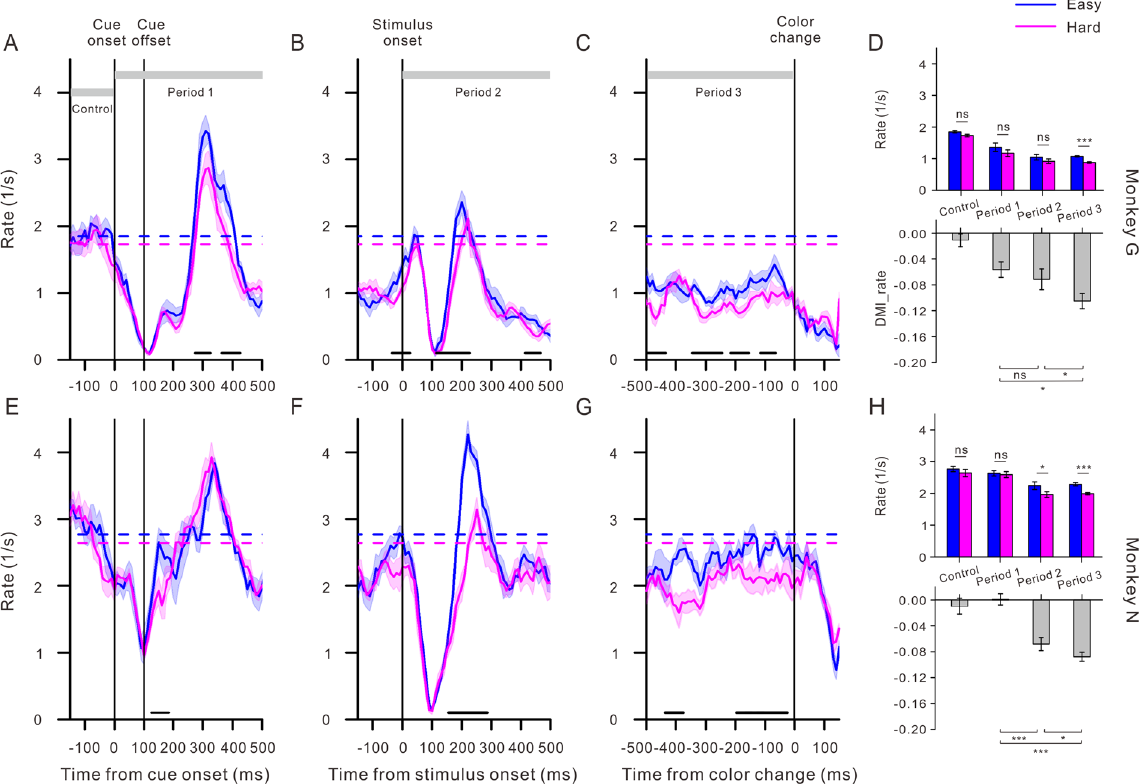
Figure 2. The temporal dynamics of the microsaccade rate and the modulations of perceptual load on the microsaccade rate during different time periods. ( A – C , E – G ) Temporal dynamics of the microsaccade rate during the easy (blue) and hard (pink) tasks for monkeys G (top panels) and N (bottom panels). The four vertical black lines indicate cue onset, cue offset, stimulus onset and target color change, respectively. The two horizontal dashed lines represent the baseline rate of microsaccades that occurred 150 ms before the cue onset (blue for the easy task and pink for the hard task). The gray lines at the top show the times of the Control and Periods 1, 2 and 3 in Fig. 1. The black lines at the bottom of each plot denote the periods in which the microsaccade rate under the two conditions differed significantly ( p < 0.05, Student t test). ( D , H ) Comparisons of the perceptual load modulation on the microsaccade rate during different periods. For each monkey, the top panel shows the average microsaccade rate during the easy (blue) and hard (pink) tasks within different periods. The bottom panel shows the perceptual load modulation induced by task difficulty on the microsaccade rate (DMI). Error bars in all panels indicate SEM, and asterisks represent statistical significance ( *** p < 0.0001, ** p < 0.001, * p <